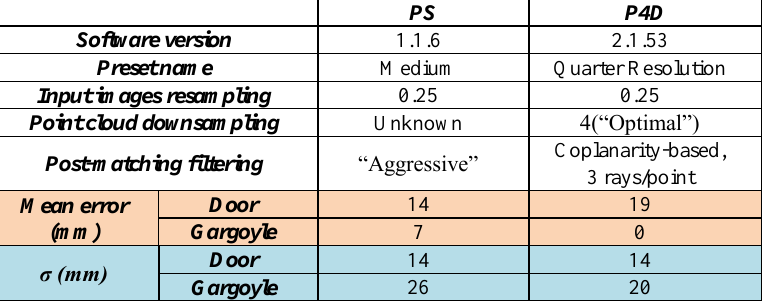
Table 3. Dense matching settings for the St-Pierre Phantom 3 dataset and the results of its comparion to laser scanner